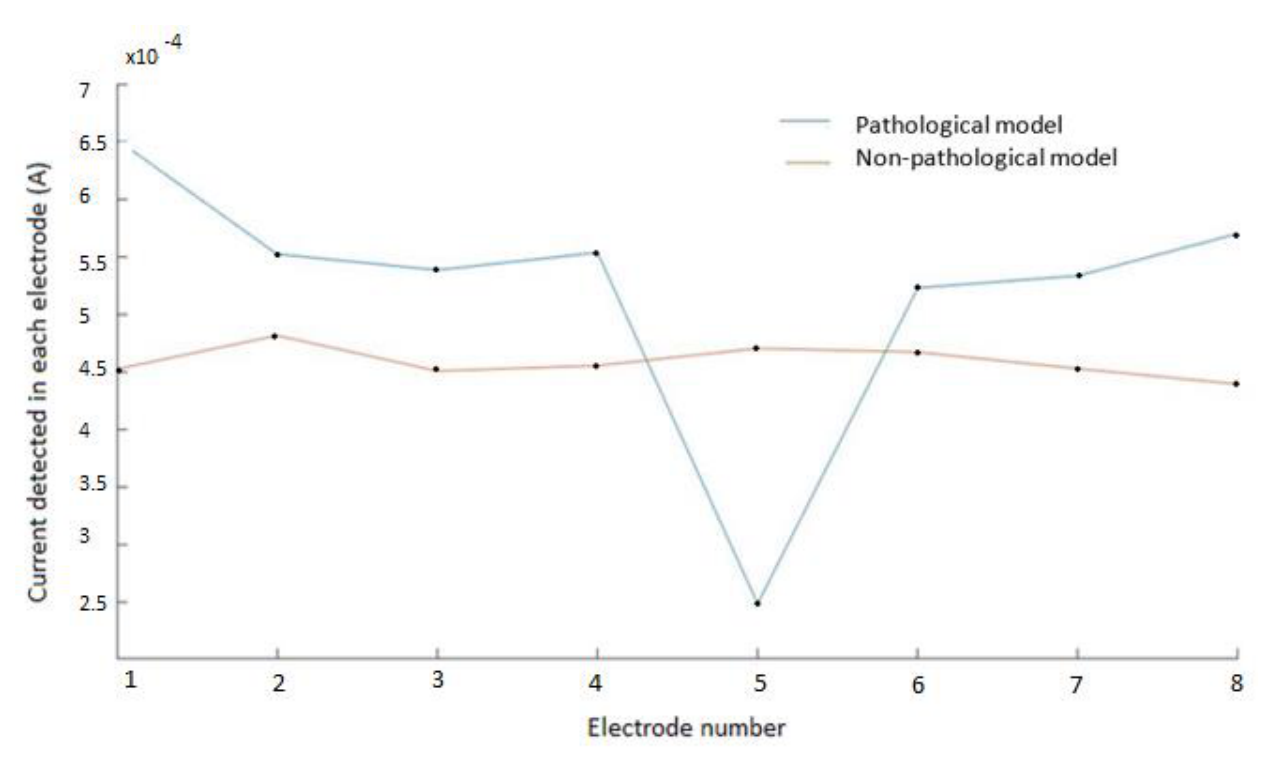
Figure 7. Electrical current measured in each electrode for the pathological model and the non−pathological model. Electrodes 1 and 2 represent the excitation electrodes, and electrode 5 is the electrode close to the modelled atheromatous plaque, as in Figure 2. The drop in the measured voltage for electrode 5 corresponds well with the presence of the atheromatous plaque. Similar results are obtained for other configurations.